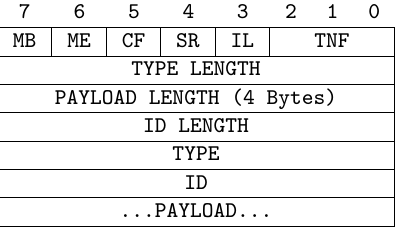
Figure 2. Structure of NDEF records. Table 2. NDEF Type Name Format values.